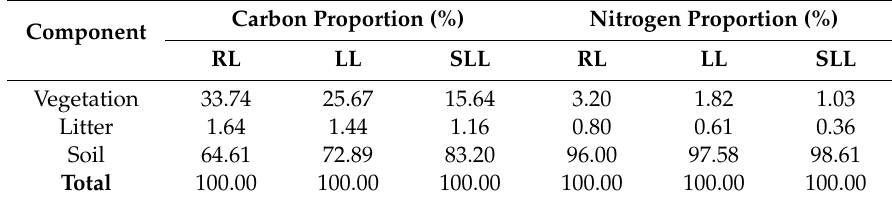
Table 11. Ecosystem carbon and nitrogen distributions in the three types of larch forest ecosystems.